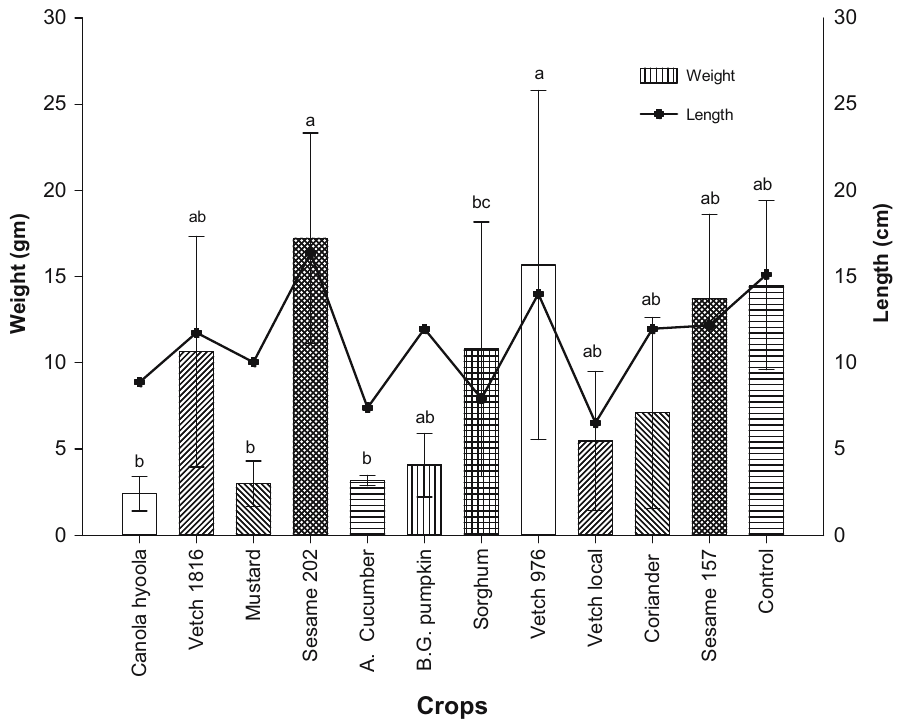
Figure 4: E ff ects of arti fi cial inoculation with Meloidogyne spp. and 11 trap crops on fresh root weight ( g/plant ) ( left - axis ) and root length ( cm/plant ) ( right - axis ) of lettuce plants. The standard deviation of the means is designated by the error bar for each mean. Means followed by the same letter are not signi fi cantly di ff erent ( SNK, P > 0.05 )